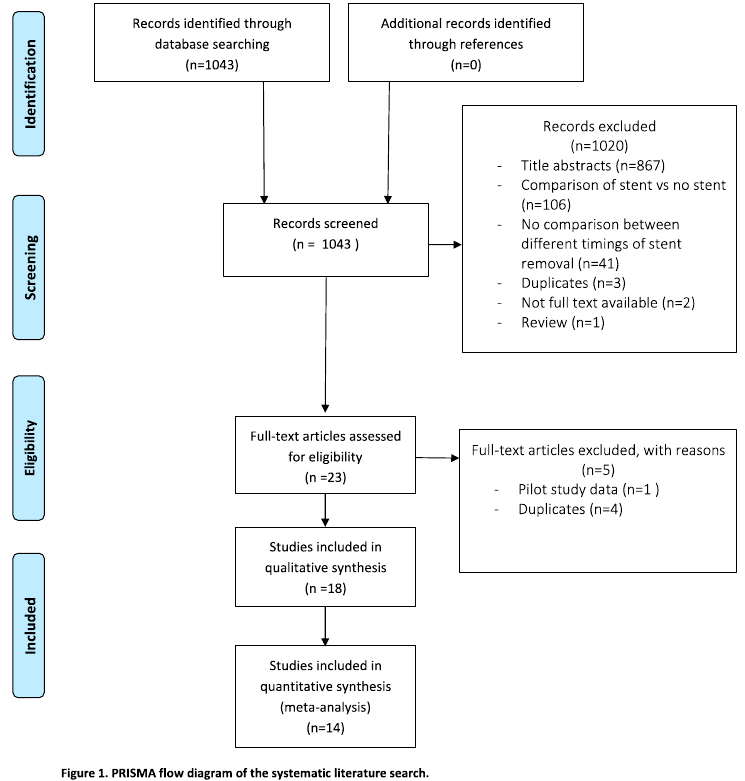
Figure 1. Preferred Reporting Items for Systematic Reviews and Meta-Analyses (PRISMA) flowchart.